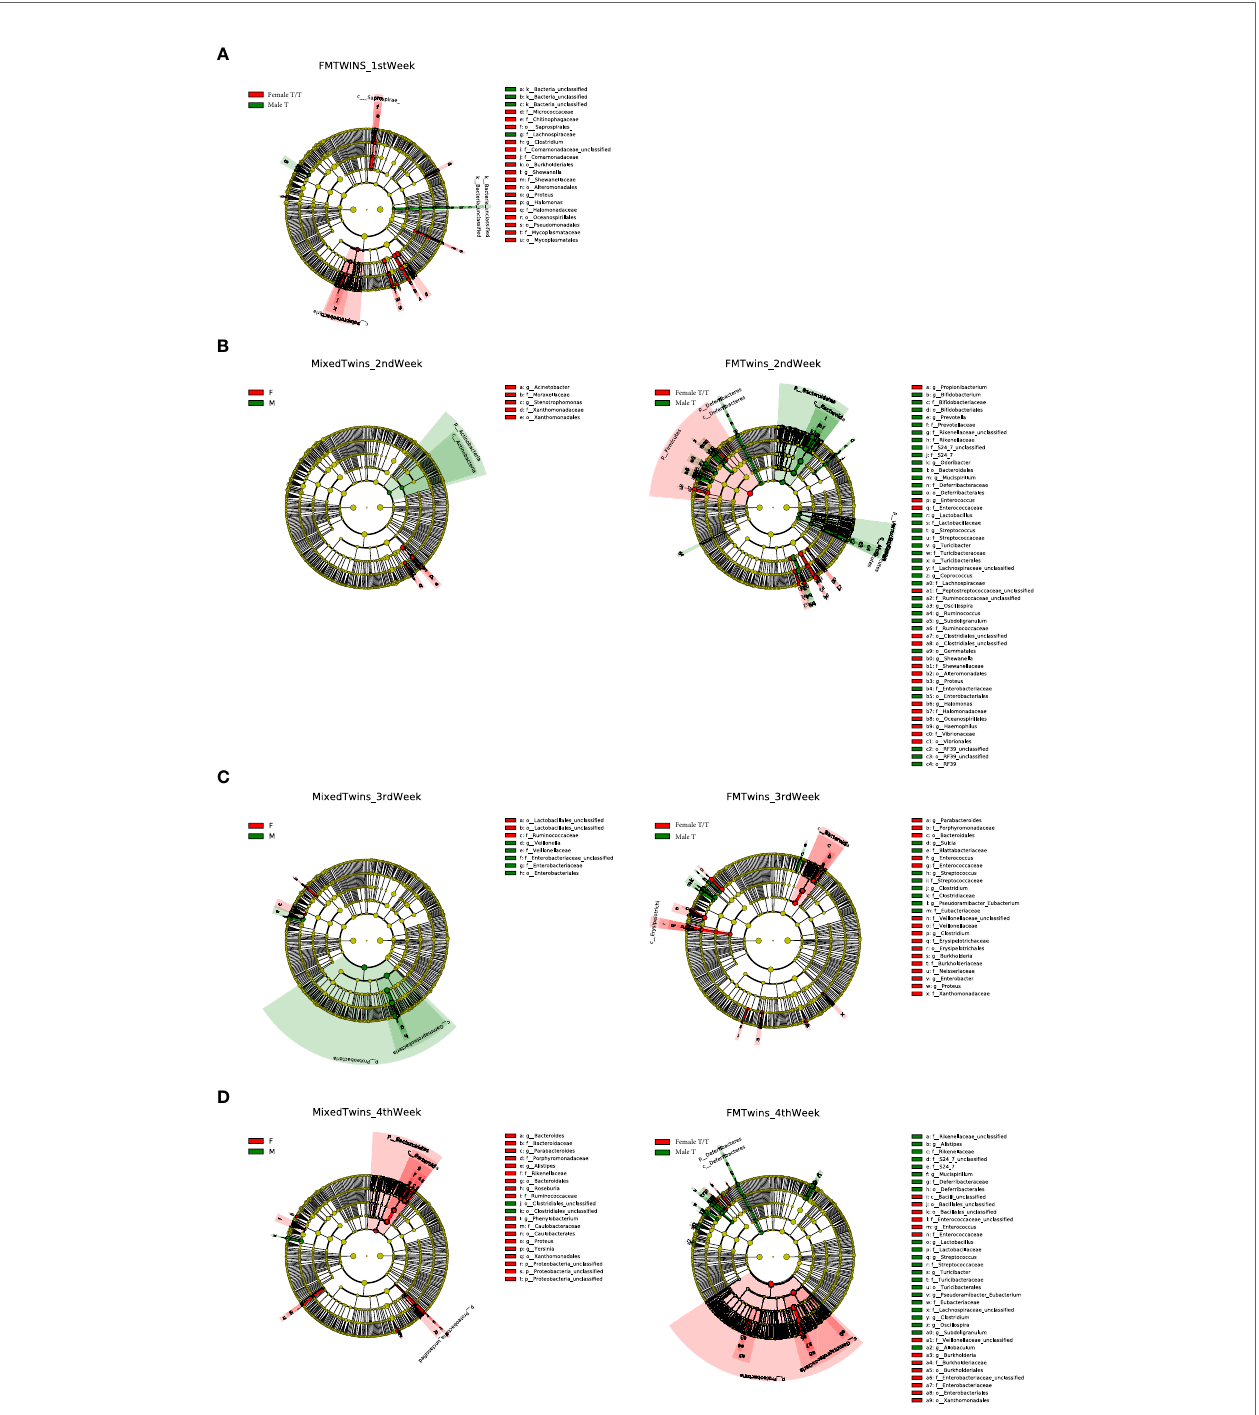
FIGURE 6 | Compositional difference of gut microbiota between Twins/Triplets. The alpha value for the factorial Kruskal – Wallis test was set to 0.05 as well as for the pairwise Wilcoxon test, and the threshold on the logarithmic LDA score for discriminative features was set as 2.0. (A – D) show different compositions between male and female infants in the 1st, 2nd, 3rd, and 4th week of NICU stay, respectively. (A) . The compositional difference of gut microbiota between Female T/T and Male T in the 1st week of NICU stay. (B) Difference between female and male co-twins of the Mixed T/T pairs (left); difference between Female T/T and Male T in the 2nd week of NICU stay (right). (C) Difference between female and male co-twins of the Mixed T/T pairs (left); difference between Female T/T and Male T in the 3rd week of NICU stay (right). (D) Difference between female and male co-twins of the Mixed T/T pairs (left); difference between Female T/T and Male T in the 4th week of NICU stay